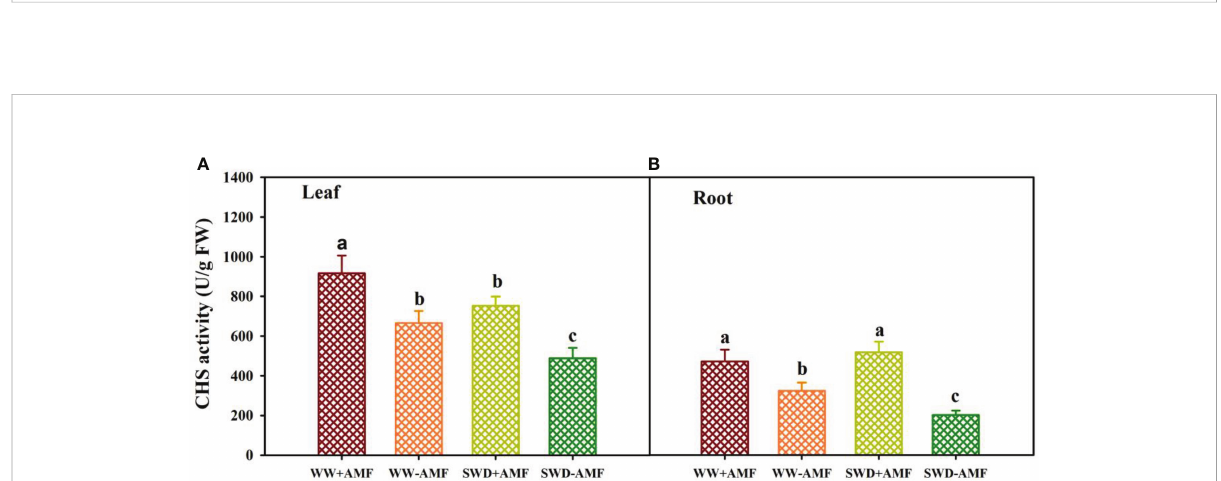
FIGURE 7 CHS activity in leaf (A) and root (B) of trifoliate orange seedlings in response to soil water de fi cit and Funneliformis mosseae inoculation. Data (means ± SD, n = 4) followed by different letters above the bars indicate signi fi cant ( P < 0.05) differences between treatments. See Figure 5 for the